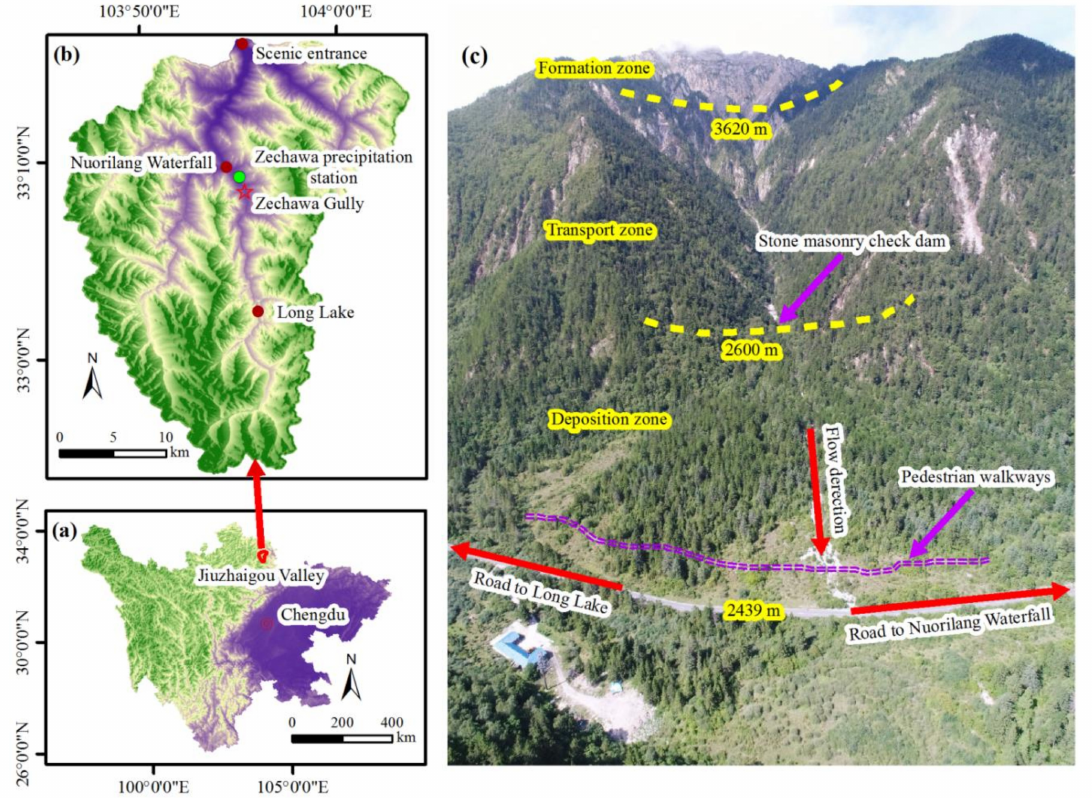
Figure 1. Location of Zechawa Gully and its full view. ( a ) Location of Jiuzhaigou Valley in Sichuan Province; ( b ) Location of Zechawa Gully in Jiuzhaigou Valley; ( c ) The full view of Zechawa Gully. The flow direction of the debris flow is perpendicular to the pedestrian walkways and the scenic road (from Nuorilang Waterfall to Long